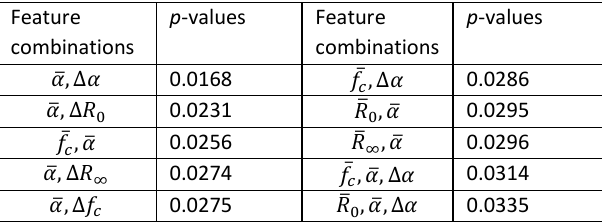
Table.2: p -values from MANOVA using EIS data taken at initial colposcopy of 569 women for evaluation of prognostic value of EIS